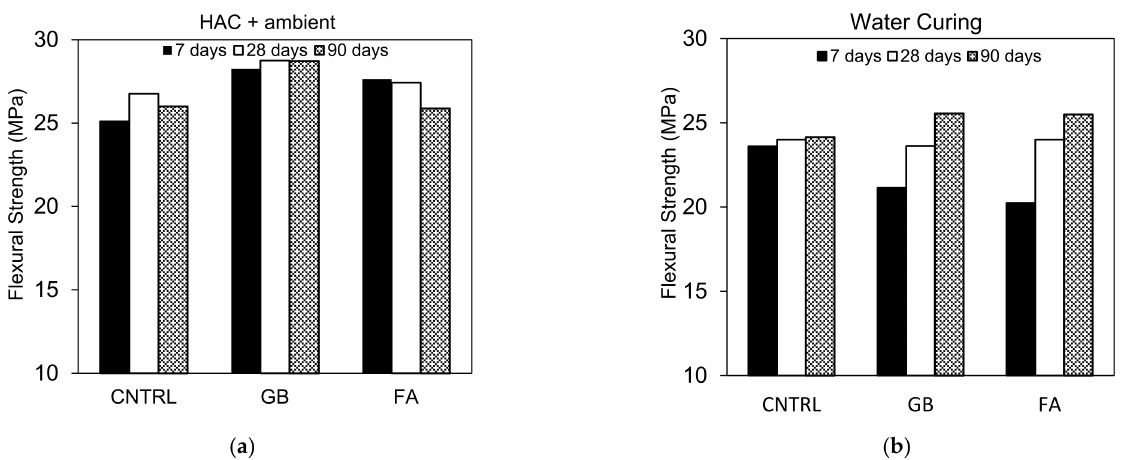
Figure 6. Flexural strength development. ( a ) HAC + ambient; ( b ) water